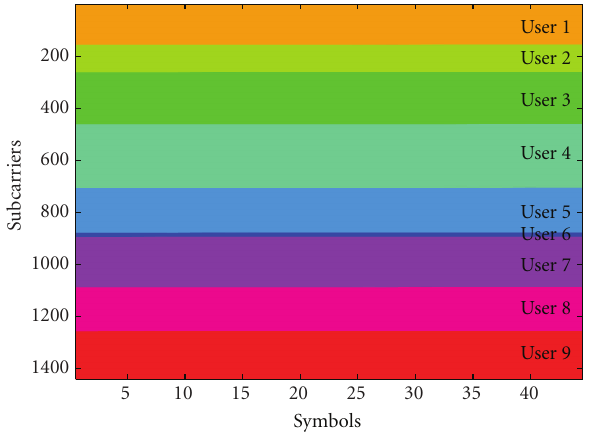
Figure 9: Allocation of symbols to videos with optimal allocation.